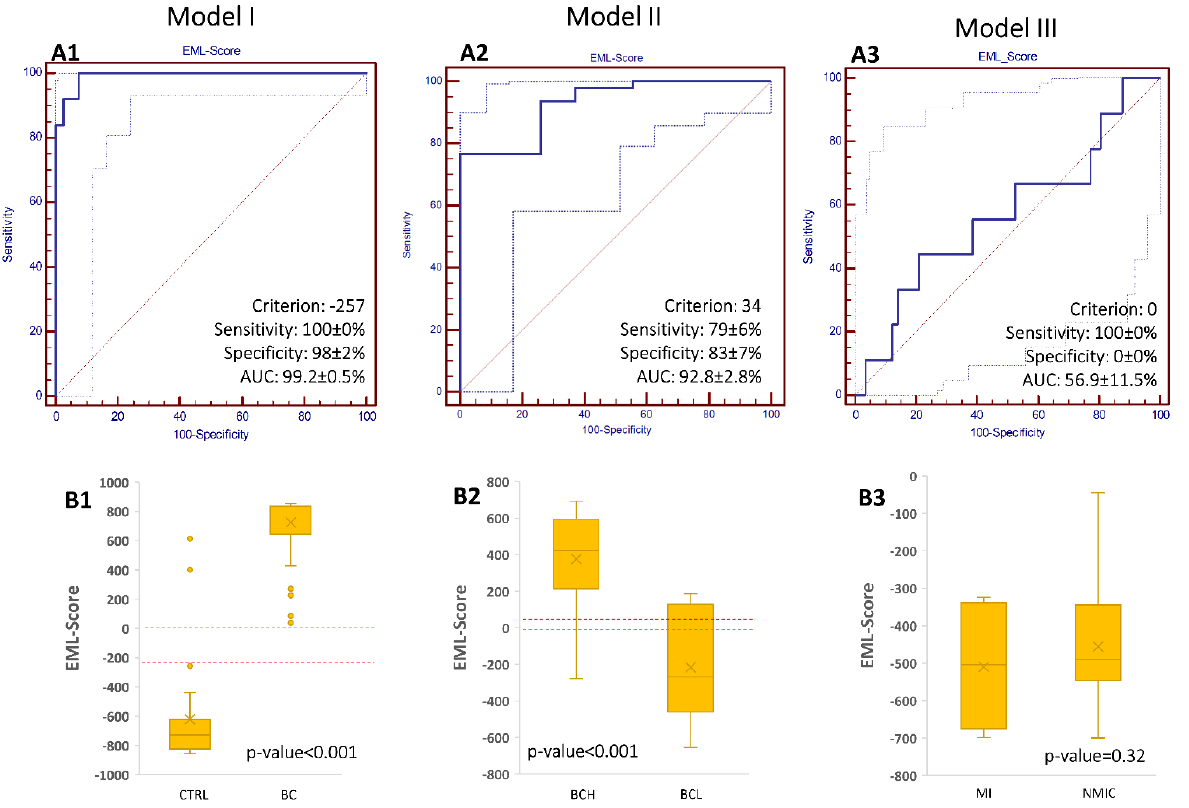
Figure 3. Ensemble machine learning (EML) models discriminating healthy and bladder cancer subjects (Model I); bladder cancer patients according to their grade (high-grade BCH, or low grade BCL) (Model II) and bladder cancer patients according to the muscle invasiveness (non-muscle invasive NMIC, or muscle invasive MIC) (Model II). Panel ( A ) reports the Receiver Operating Characteristic (ROC) curves obtained using the cut-off evaluated by means of the Youden’s Index (red line in B1). Panel ( B ) reported the EML-scores among the studied classes.